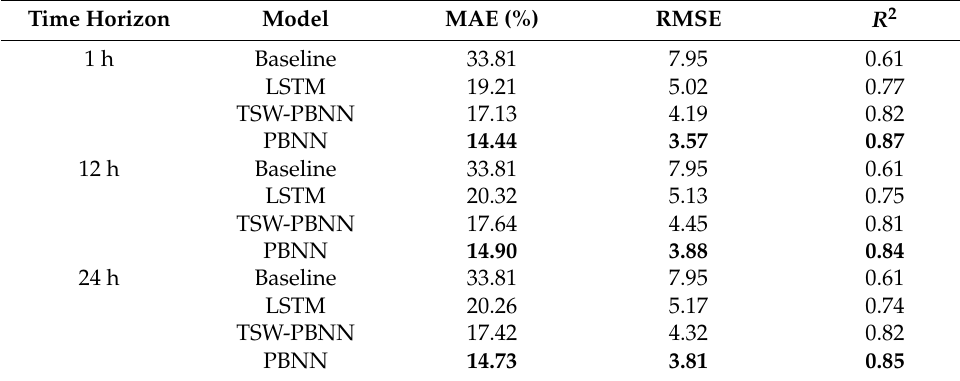
Table 9. Energy consumption prediction error of Building